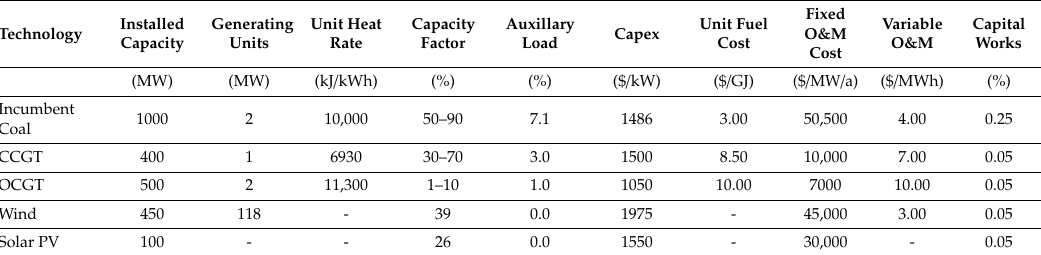
Table 1. Plant cost assumptions.